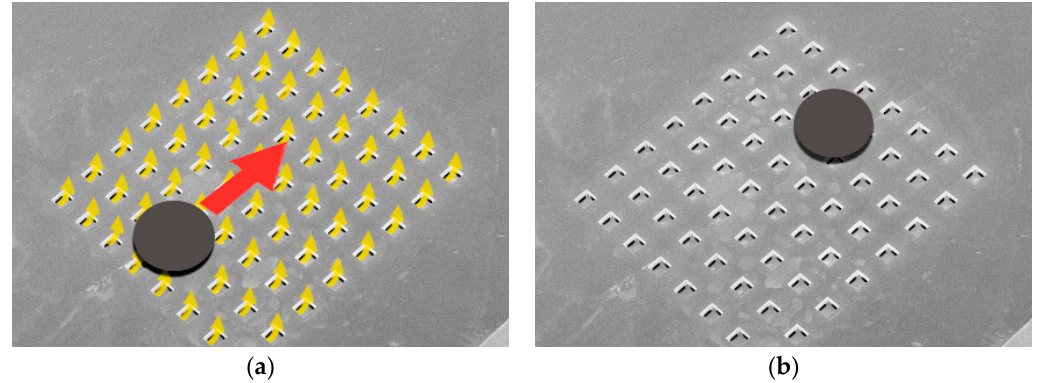
Figure 5. Working principle of the tilted-air-jet array. ( a ) Blowing to one direction. ( b ) Movement of the object.